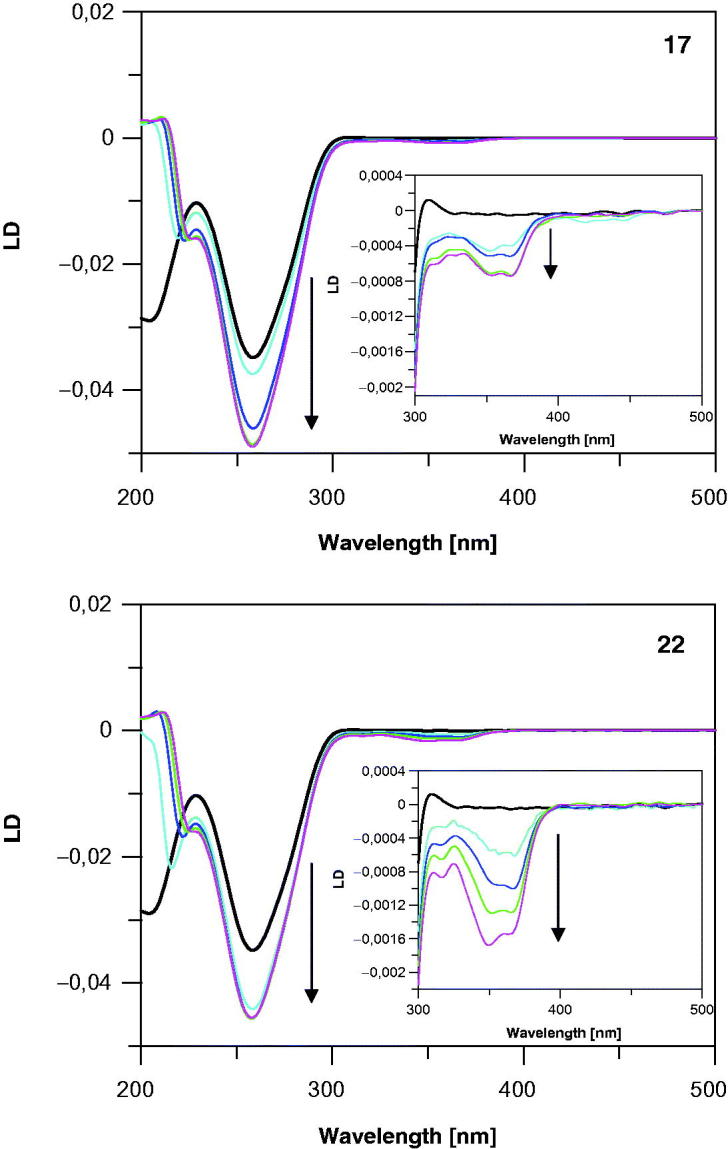
LD spectrum of ctDNA (black line, 310 µM) in the absence and in the presence of studied 7-MEOTA-THA thio-/ureas 17 and 22 (color lines, 0–0.1 mM) in 10 mM Tris–HCl buffer (pH 7.4).